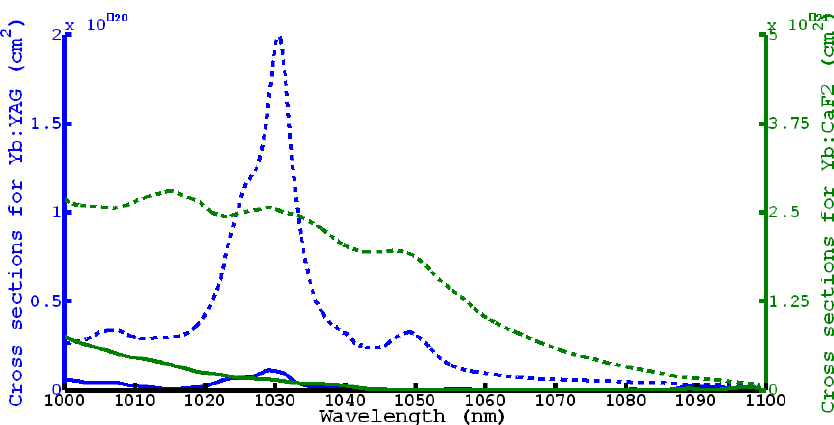
Figure 1. Absorption (solid lines) and emission (dashed lines) for Yb:CaF Yb:YAG (blue). Adapted from Ref. [13].